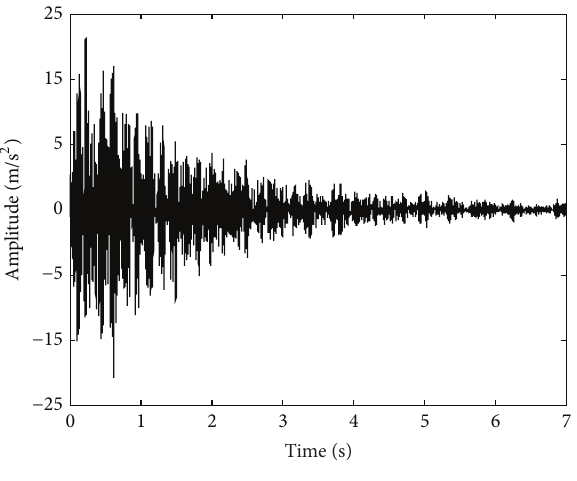
Figure 6: Measured vertical